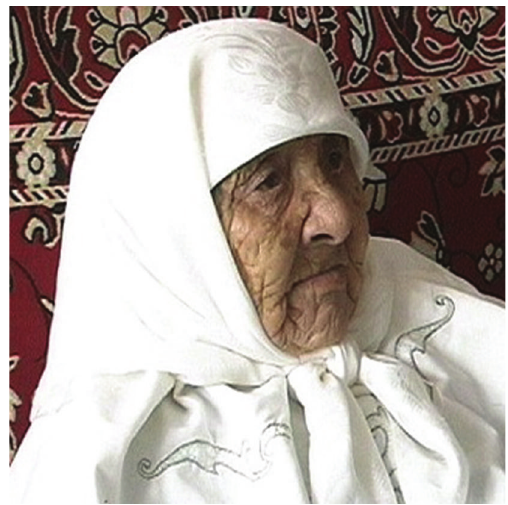
Figure 4: Sakhan Dosova’s family and Kazakhstan o ffi cials claimed, as of April 1, 2009 that she was 130 years old. She died a month later. Photo permission from Radio Free Europe/Radio